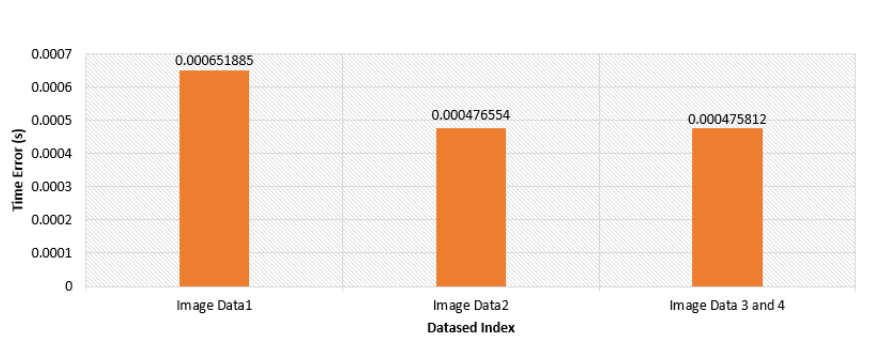
Figure 8. Detailed differences between the actual and designed line-times of the first 1000 scan lines of Image Data 1.